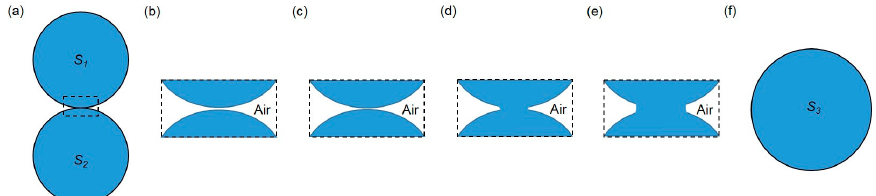
Figure 14. Schematic of the whole coalescence process of liquid droplets. ( a ) Two contacting liquid droplets with surface area S 1 and S 2 respectively; ( b ) magnification of contact area with an air layer separating two droplets; ( c ) the air layer gets thinner as the shape deformation of droplets continues; ( d ) the rupture of the interface and the appearance of a liquid bridge; ( e ) the liquid bridge grows exponentially following a certain power scaling law; ( f ) the formation of a bigger daughter droplet with a smaller total surface area ( S 3 < S 1 + S 2 ).